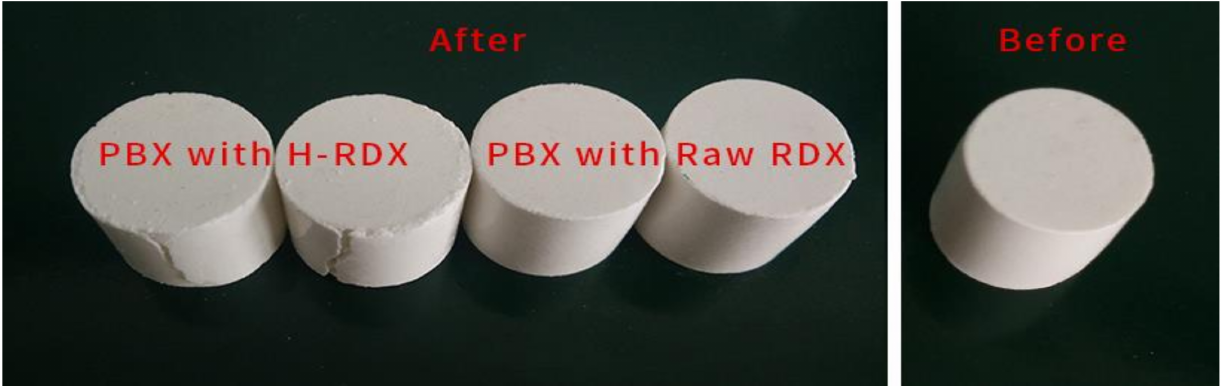
Figure 3. Comparison of PBX after compressive strength